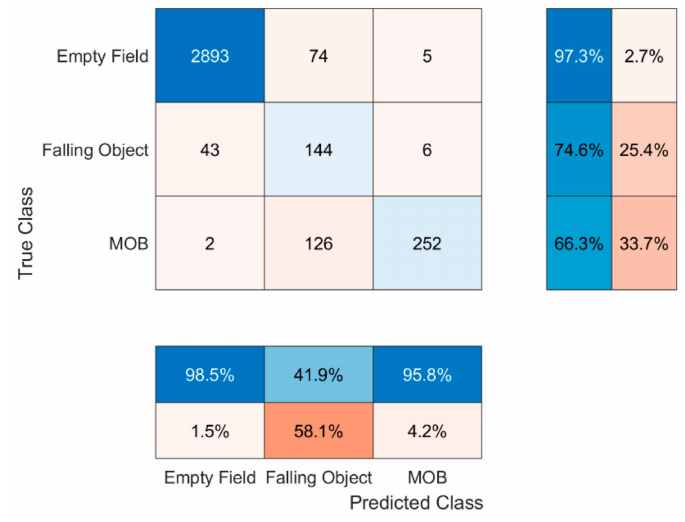
Figure 9. C1 (cid:48) s confusion matrix.